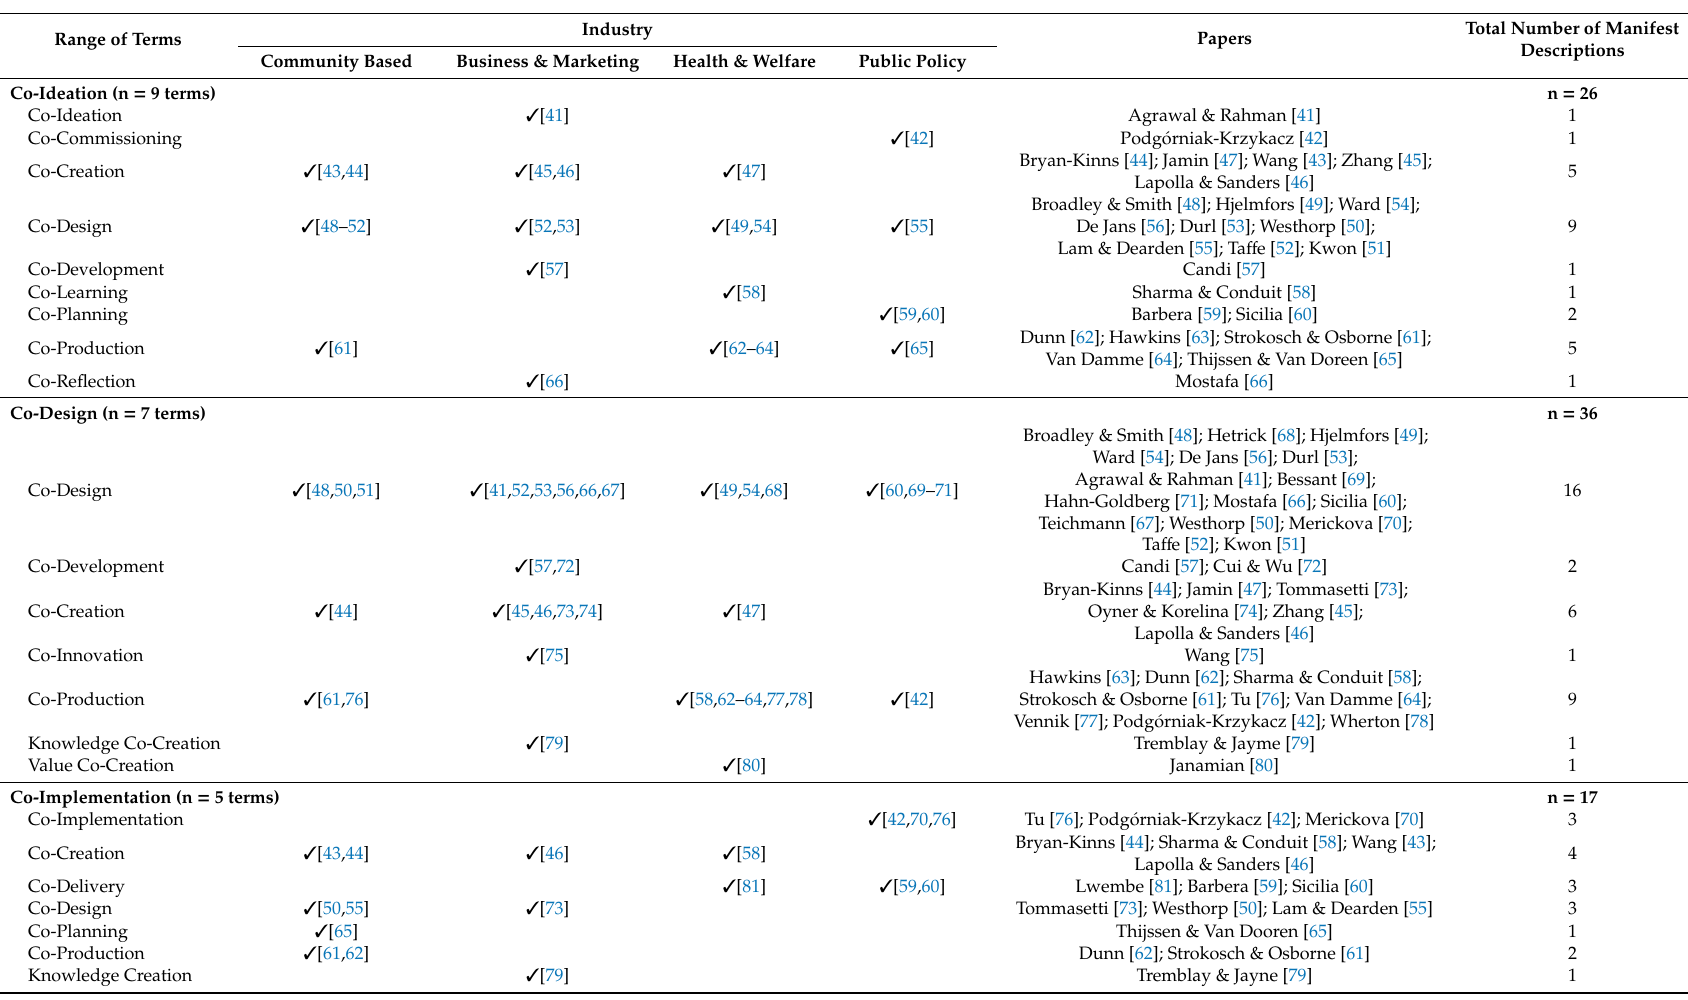
Table 2. Use of co-creation-related terms in papers with a manifest description of their co-creation process, published in 2014–2018 (n = 42 papers). Range of